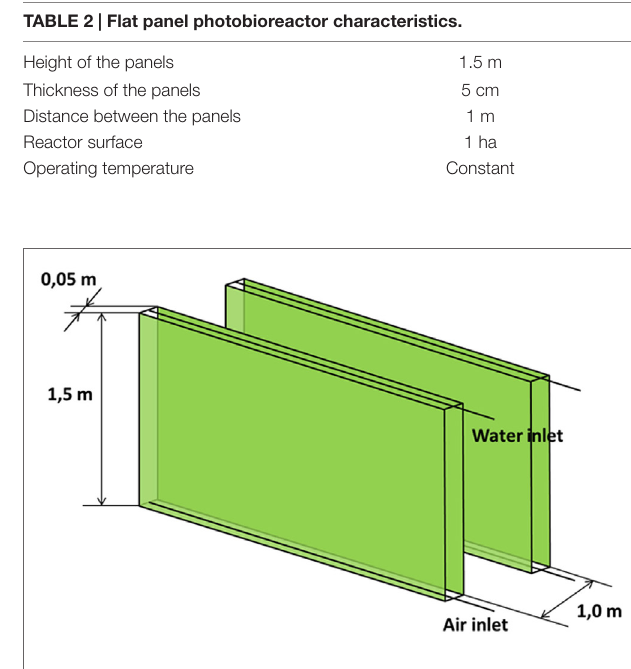
FigUre 1 | raceway open pond